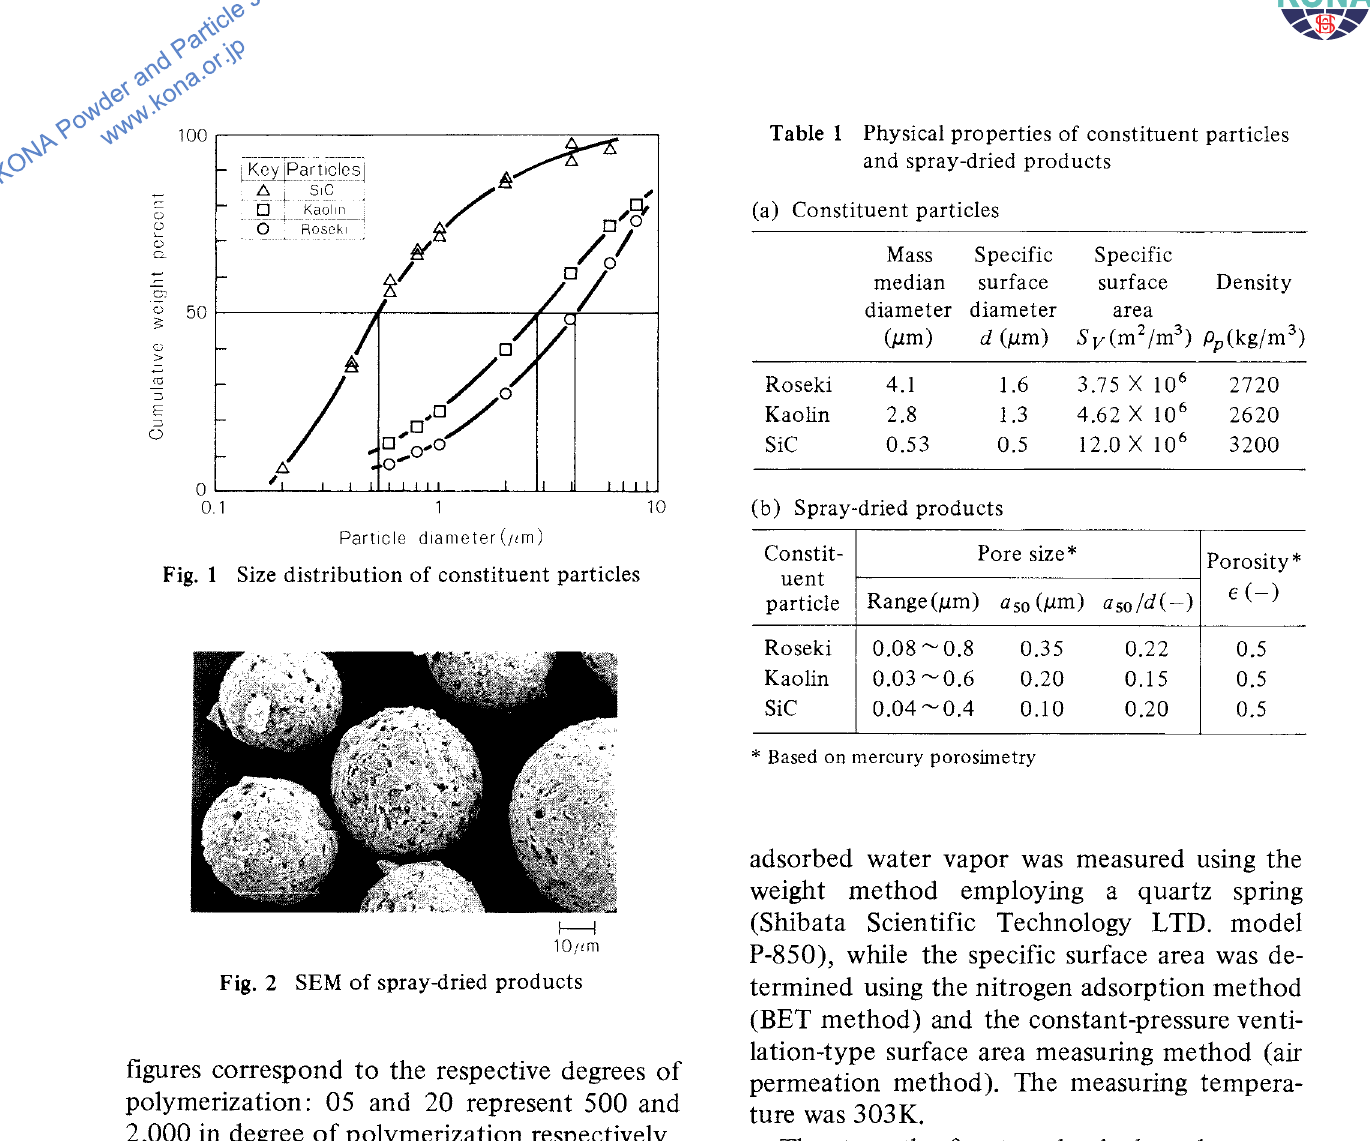
Table 1 Physical properties of constituent particles and spray-dried